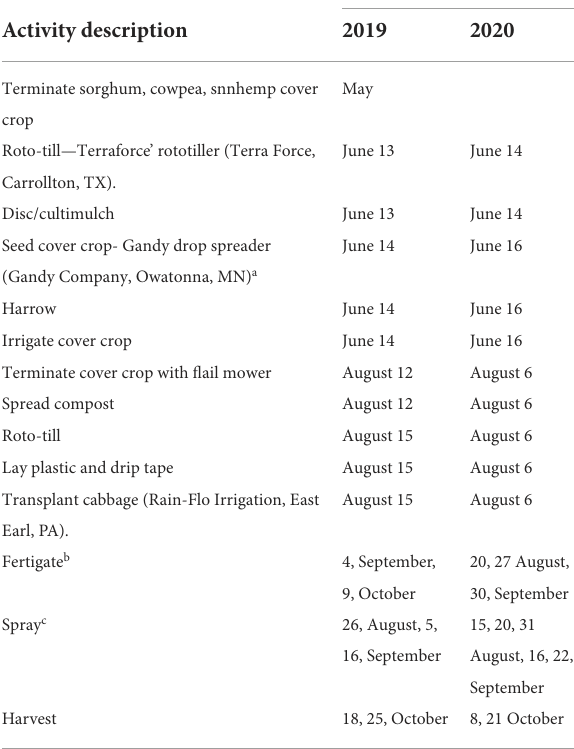
TABLE 3 The sequence of field activities carried out at the Iowa State Horticulture Research Farm 2019 and